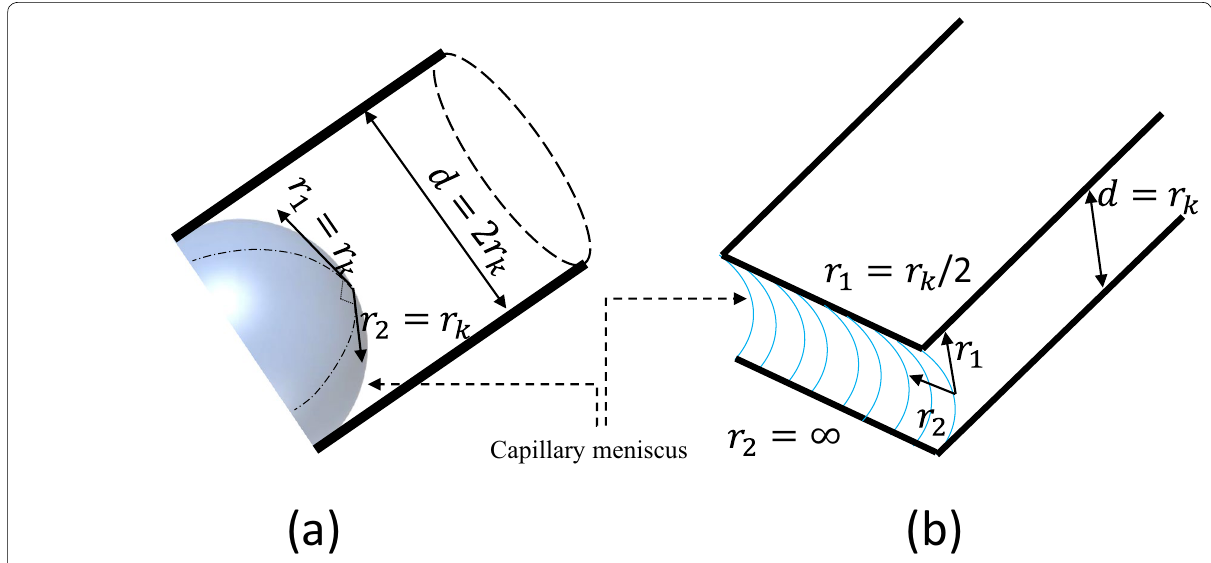
Fig. 5 Illustration of the relation between Kelvin radius and pore size a in a cylindrical pore and b in a slit-shape